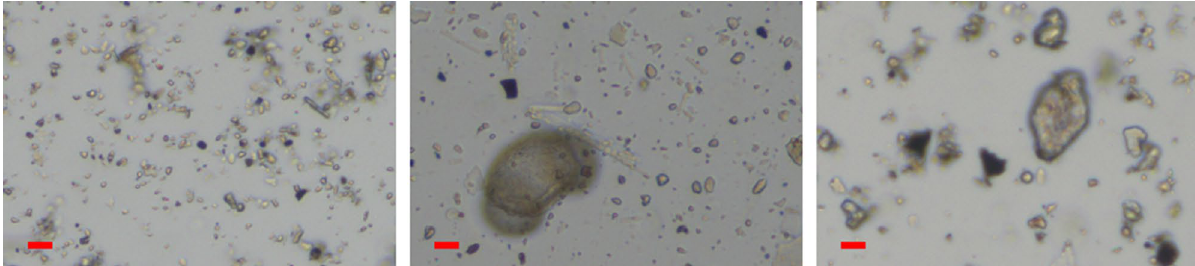
Figure 1. Morphology of PM 0.3–2.4 (left), PM >2.4 (centre), and UA (right). The length of the bar in each photograph is 10 µm. PM 0.3–2.4 particle matter 0.3–2.4 µm, PM > 2.4 particle matter larger than 2.4 µm, UA urban (TJ) such as the zonula occludens-1 (ZO-1); however, conventional two-dimensional cell cultures may not be able to predict biological responses as essential cellular functions in living tissues are missing 15 . Cao et al. demon-